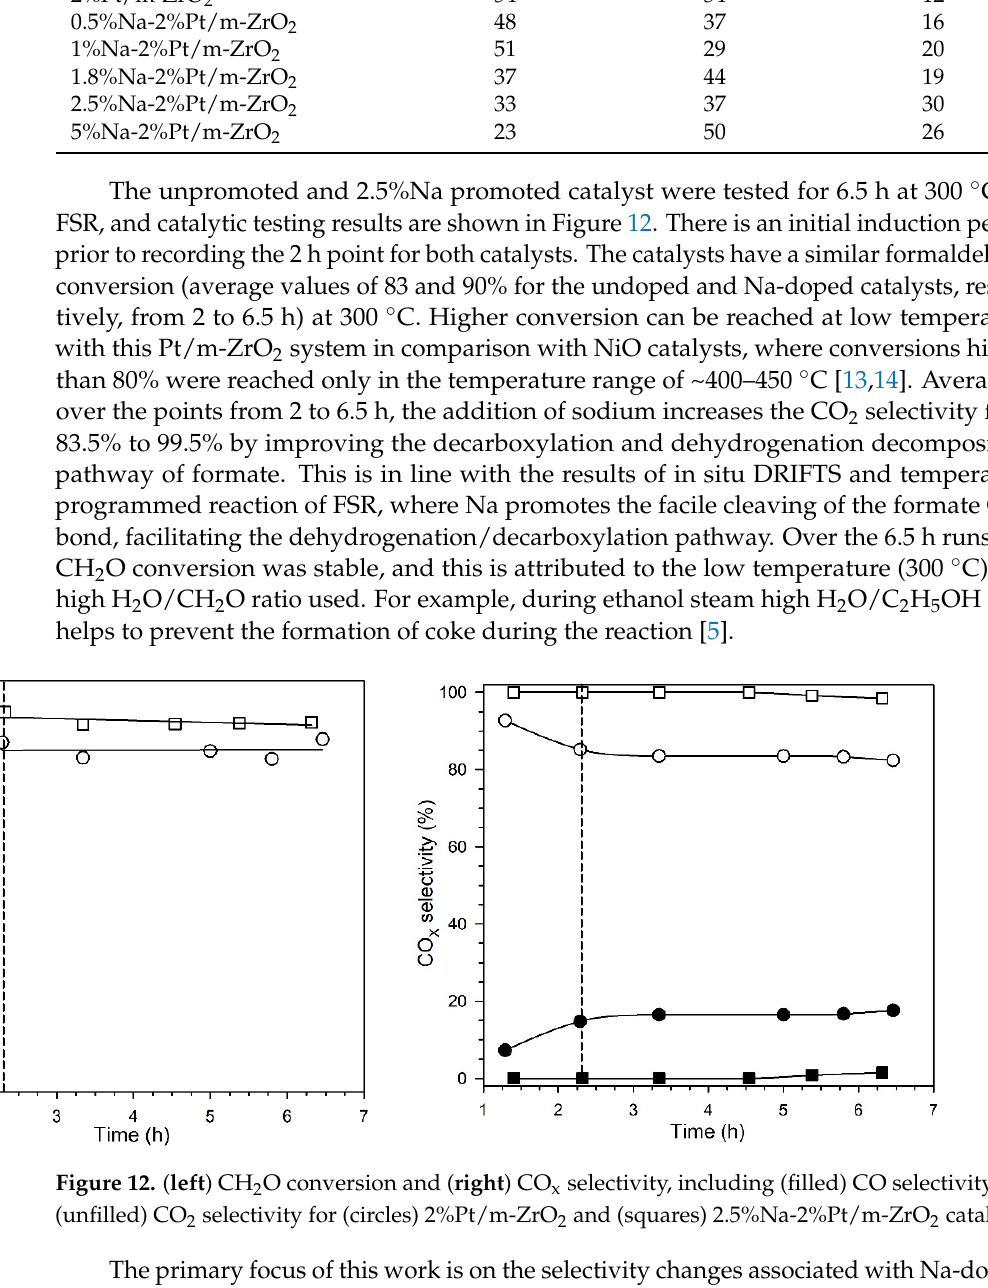
Figure 13. In situ DRIFTS of steady state formaldehyde steam reforming at 300 °C for ( a ) 2%Pt/m- ZrO 2 , and the same catalyst with ( b ) 2.5%Na. Conditions: 50 ccm, 4.5%H 2 O, 0.72%CH 2 O, balance He.